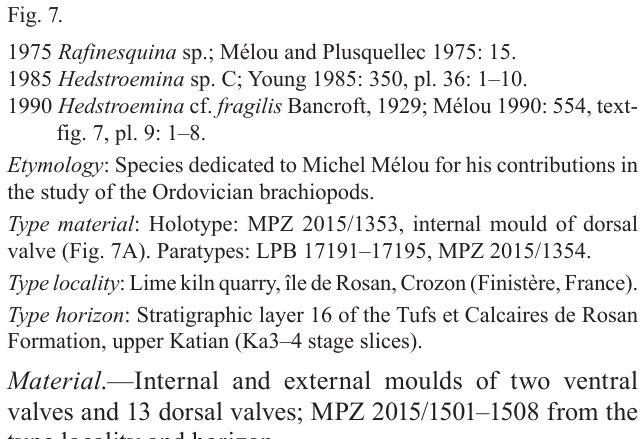
1975 Rafinesquina sp.; Mélou and Plusquellec 1975: 15.